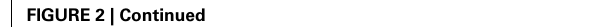
FIGURE 2 | Continued Overview of HIV restriction byA3 enzymes. (A) Sketch depicting lifecycles of wild-type (WT) and (cid:2) Vif HIV ( (cid:2) Vif). Each virion enters a cell that expresses A3 enzymes. In theWT virus,Vif is expressed in the cell and recruits host cell CBF β for stability and CRL5 E3 ubiquitin ligase complex composed of Elongin B/C (EloB/C), Cullin5 (Cul5) and Rbx2 ( B ). In this complex,Vif acts as the substrate receptor to induce degradation of A3 enzymes. As a result, assembling virions do not encapsidate high levels of A3 enzymes and upon infection of a target cell the HIV lifecycle continues. The (cid:2) Vif HIV encapsidates A3 enzymes through an RNA and